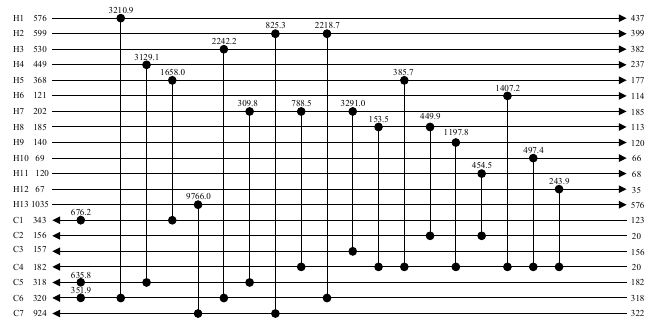
Figure 12. RWCE optimization results of the participatory evolutionary strategy for streams.